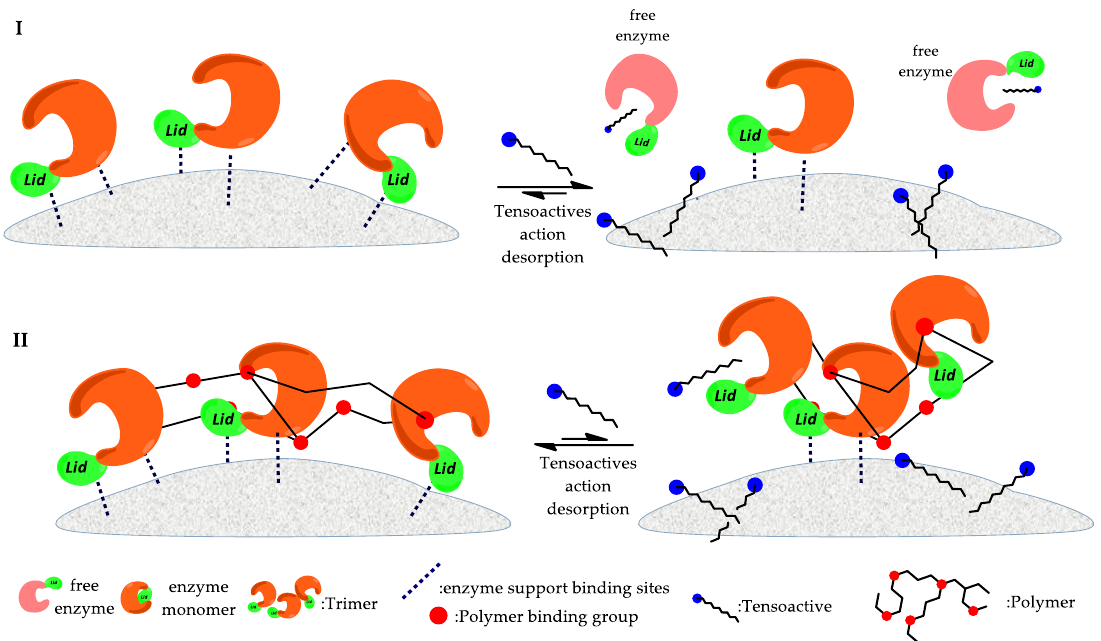
Figure 8. ( I ). Representation of lipases in monomeric form immobilized in their open conformation on a hydrophobic surface (represented in grey). In the presence of surfactants, some binding points to the support are lost, generating desorption of enzymes present in the derivative. ( II ) Representation of lipases immobilized in a hydrophobic surface crosslinked with an ionic polymer. In the presence of surfactant binding points are also lost, however here it is shown that in contrast to I there is no enzymatic desorption [161,162].